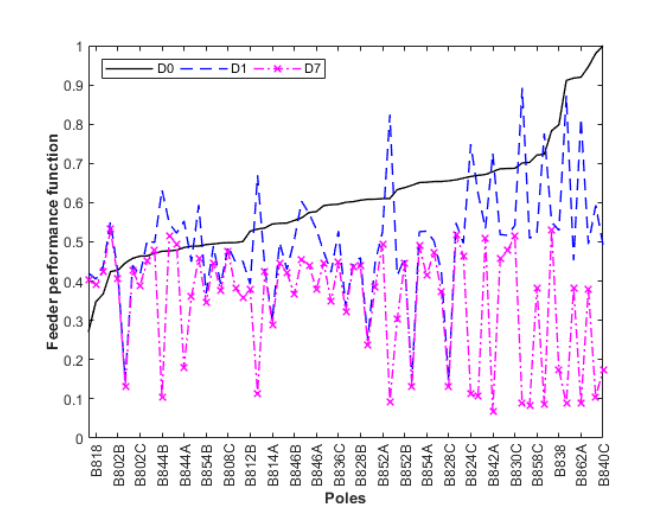
Figure 20. D function for case m = 1 and n = 0 (D0), with lightning arresters only at the transformer’s pole (D1); and lightning arresters at the transformer’s pole and at the most critical poles simultaneously (curve D7).